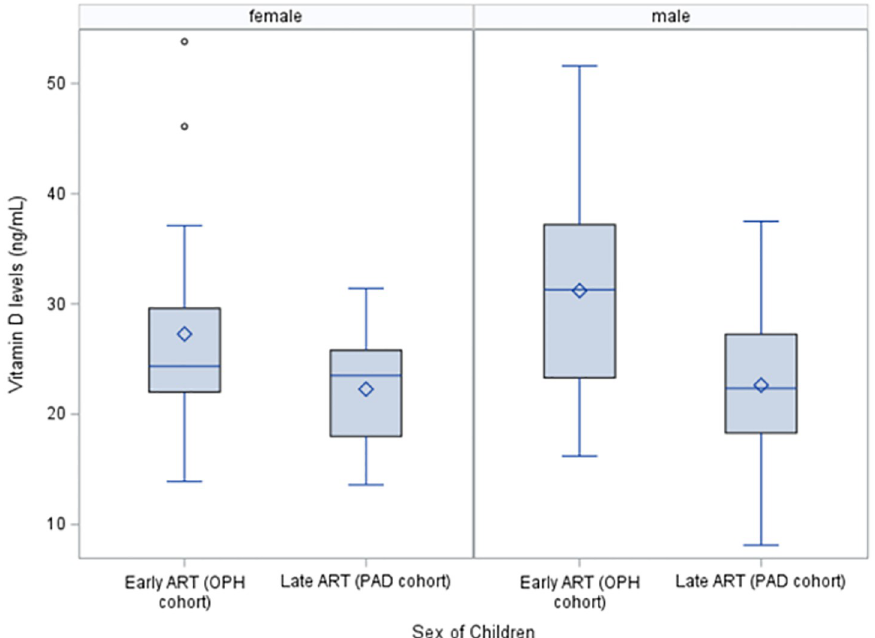
Fig 1. Box plot of vitamin D level (ng/ml) by early- and late-ART initiation and by sex of children. The middle line inside of the box is the median. The diamond inside of the box is the mean. The box represents the interquartile range (IQR, Q1 to Q3, from 25 th percentile to 75 th percentile). The upper and lower bars represent the Q1-1.5 � IQR and Q3 +1.5 � IQR. The circles outside the bar could be potential outliers.